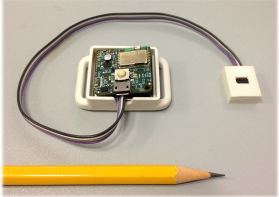
Figure 4. The D-MuSe device including a Li-poly